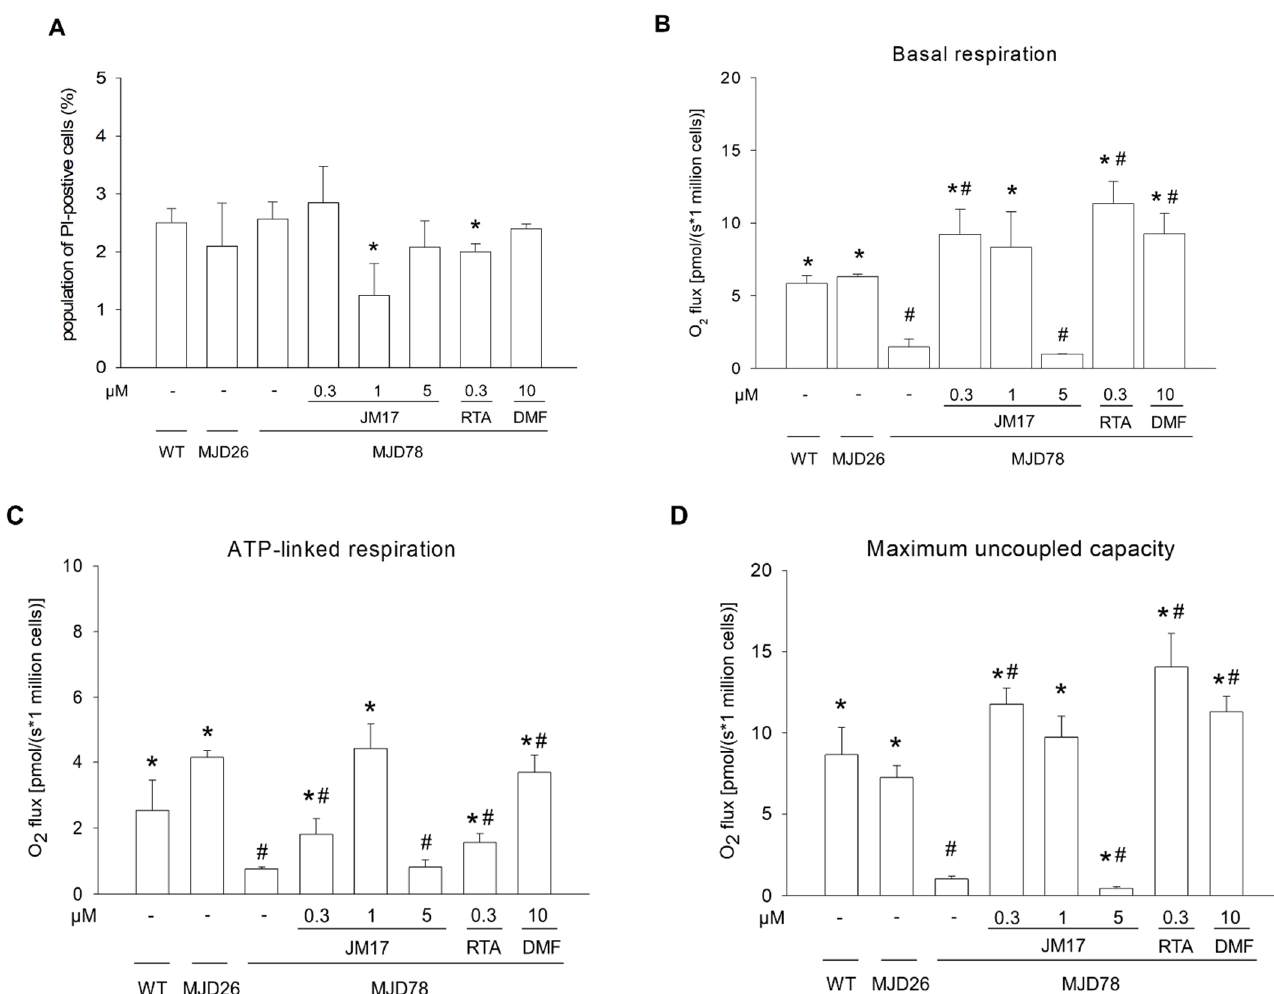
Figure 1. Functional support of cell viability and mitochondrial function. Cells were treated with or without DMSO vehicle control or with 0.3, 1, or 5 μ M JM17, 0.3 μ M RTA-408, or 10 μ M DMF for 24 h. ( A ) Cell viability was assessed by flow cytometry analysis using propidium iodide to stain dead cells. ( B ) Basal respiration, ( C ) ATP-linked respiration, and ( D ) Maximum uncoupled capacity